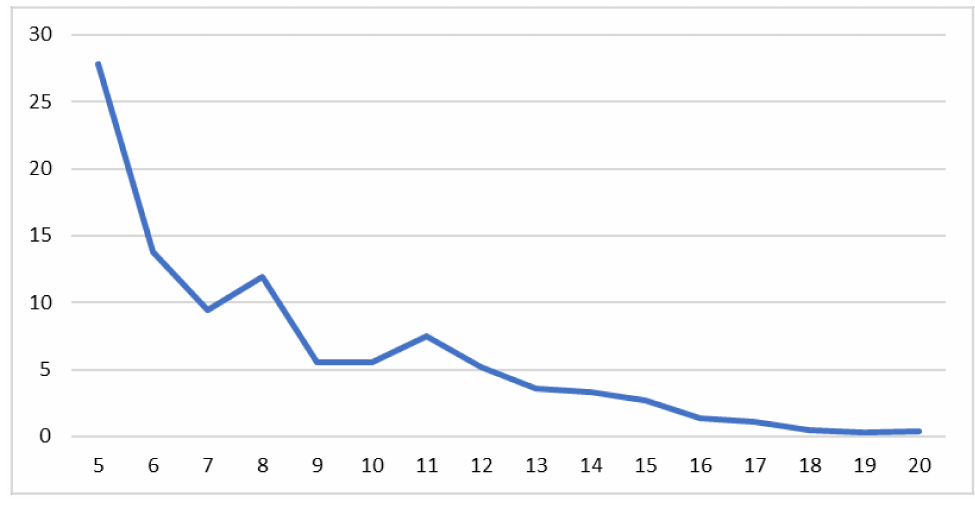
Figure 3. Risk aggregate score (v2